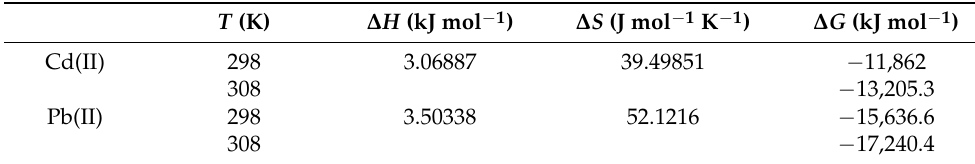
Table 3. Thermodynamic parameters for adsorption of 100 mg L − 1 Cd 2+ and Pb 2+ on HEMA/CNF copolymer at 25 and 35 ◦